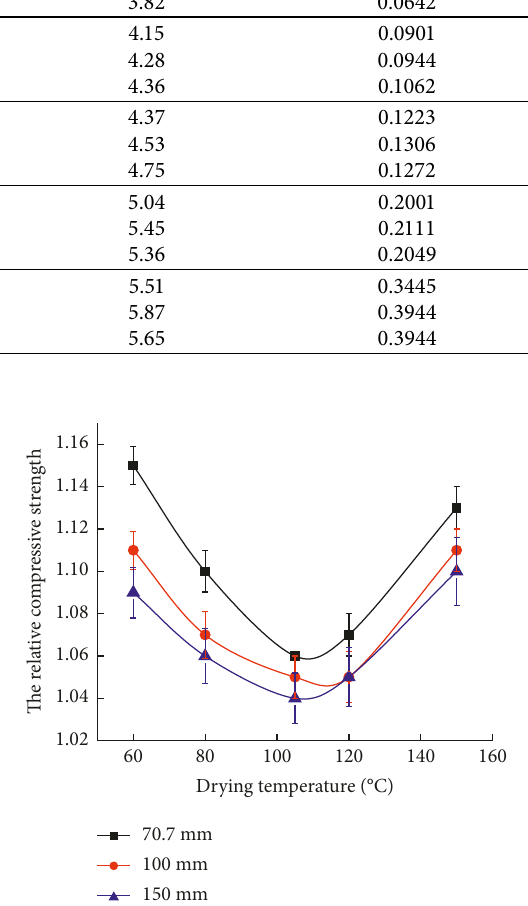
Figure 2: The relative compressive